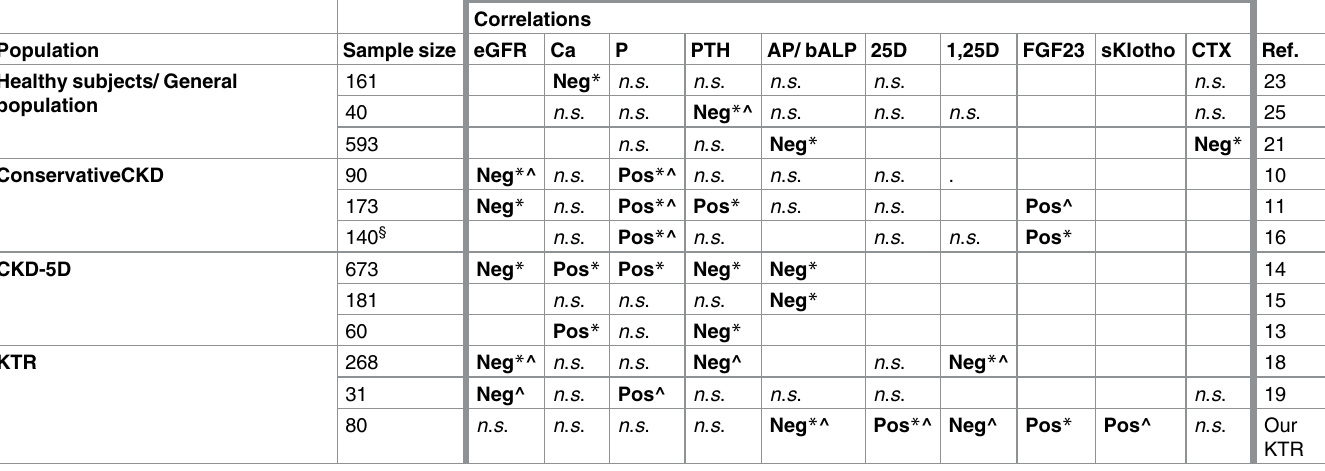
Table 4. Currently reported correlations (either linear or multivariate analysis) of serum Sclerostin levels in different clinical condition.